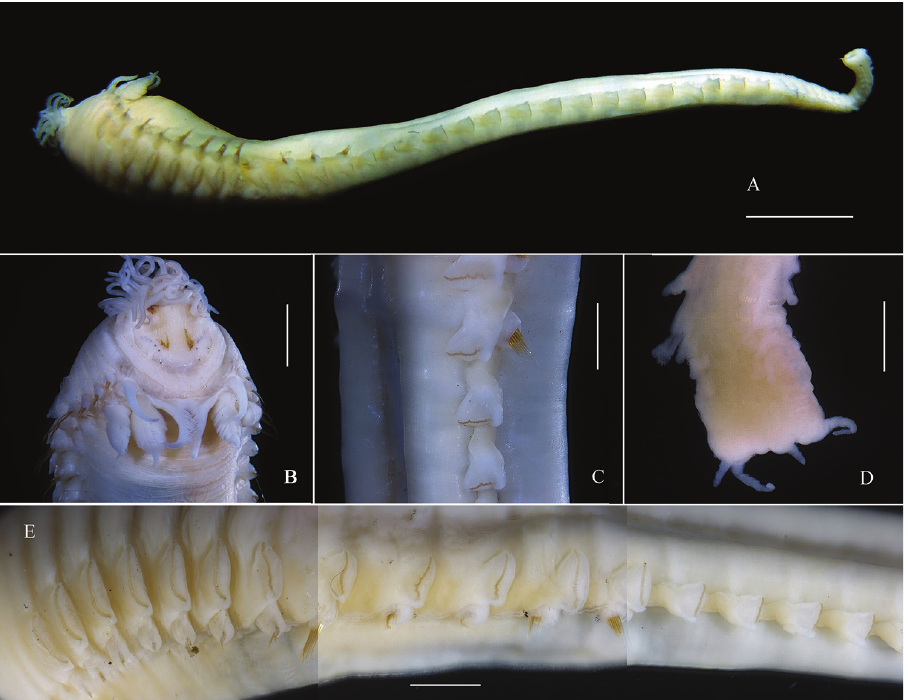
Figure 2. Phyllocomus chinensis sp. n. A whole specimen, lateral view B anterior end, dorsal view C last thoracic and first abdominal segments, lateral view D posterior region (with two pairs of long anal cirri) E consecutive variation of the neuropodia from segment 6 to segment 21. Scale bars A : 4 mm, B, E : 2mm, C–D : 1